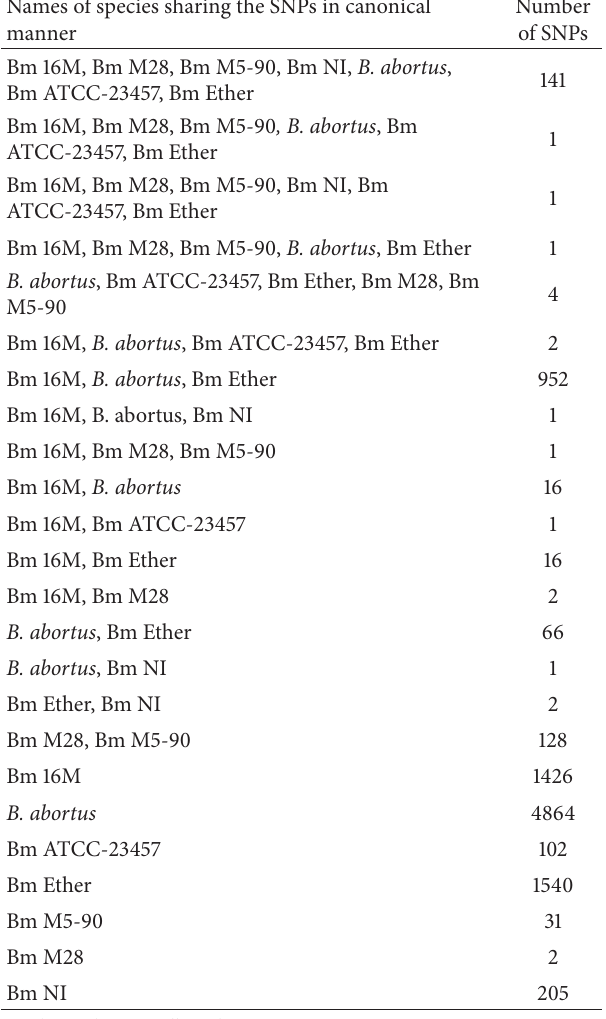
Table 5: Distribution of shared SNPs among 7 different strains of B. melitensis identified against Bm